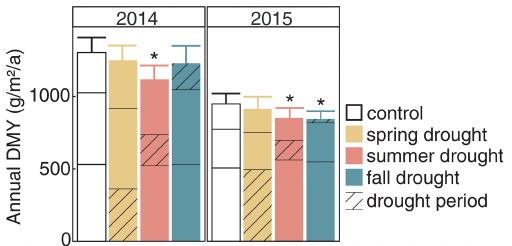
Figure 8. Annual ANPP under rain-fed control and under the three seasonal drought treatments in the years 2014 and 2015. Values shown are means across all six investigated grass species and culti- vars ( n = 6; ± SE). Bars are stacked according to growth in spring (bottom part), summer and fall (top part). Significant differences to the control are marked with an asterisk ( p < 0.05). The correspond- ing statistical analyses are shown in Table A2 in the